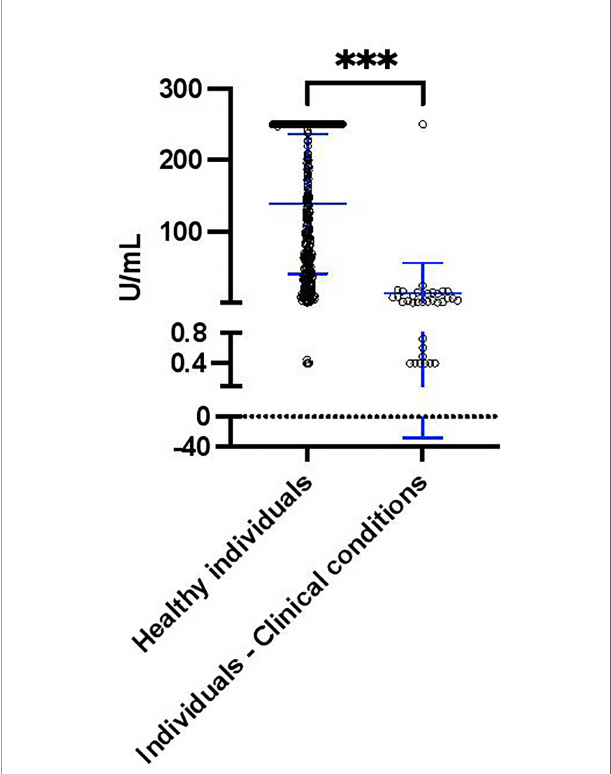
FIGURE 2 | S antibody levels in healthy individuals (n = 345) and individuals with clinical conditions (including Rheumatic, Renal, Obesity, Type 2 diabetes, Psoriasis and Multiple sclerosis, n = 34) after the second dose of the Sinopharm vaccine. Differences between individuals with clinical conditions were assessed by Mann Whitney test. The asterisks indicate ***p value < 0.001.